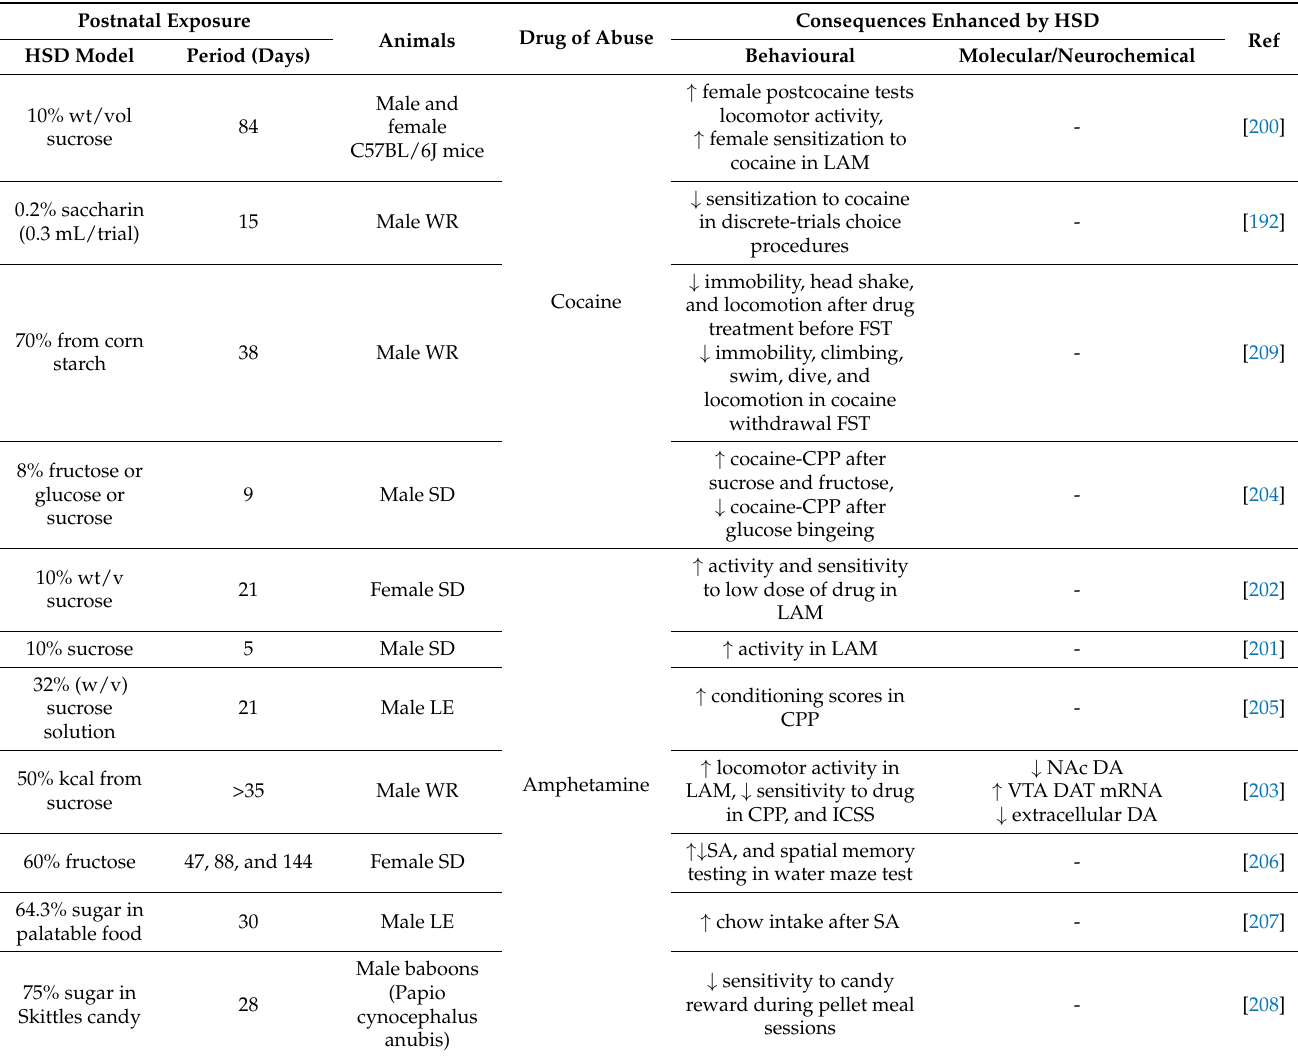
Table 4. Preclinical studies on the postnatal HSD consumption on behavioural and molecular or neurochemical consequences after drugs of